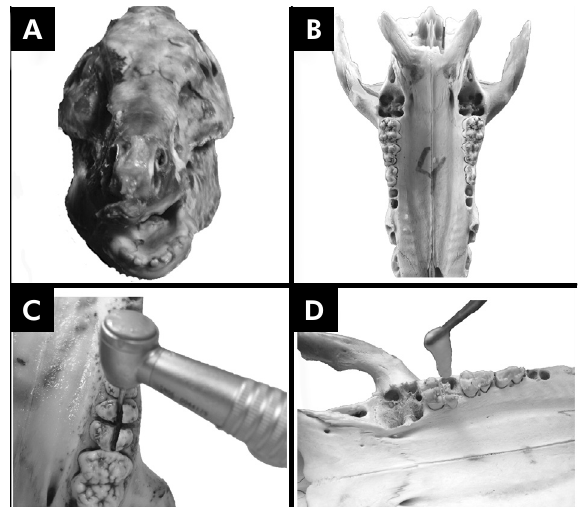
Figure 1. Preparation of samples: A) Pig’s head; B) Macerated swine maxilla; C) Odontosection; D) Application of perchloric